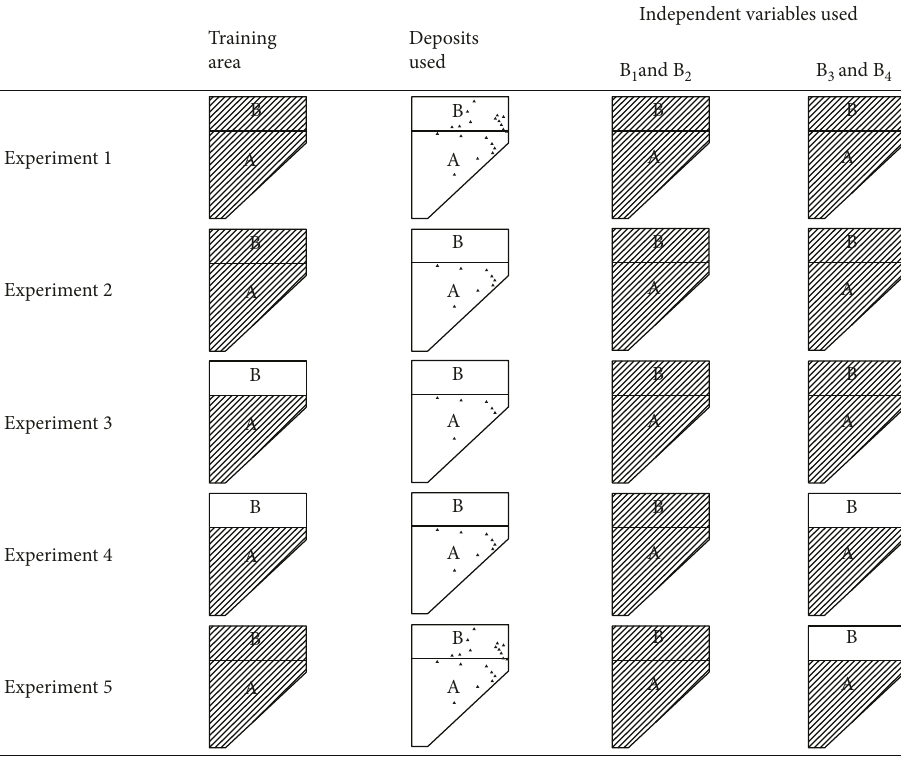
Figure 5: Four experiments in which the 20 gold deposits were related to the four binary input layers for the study area shown in Figure 1. Results for experiment 1 were shown in Figure 3. For the other three experiments, the study area was divided into two parts according to the east-west line in the middle while deposits and pairs of four binary layers were used as